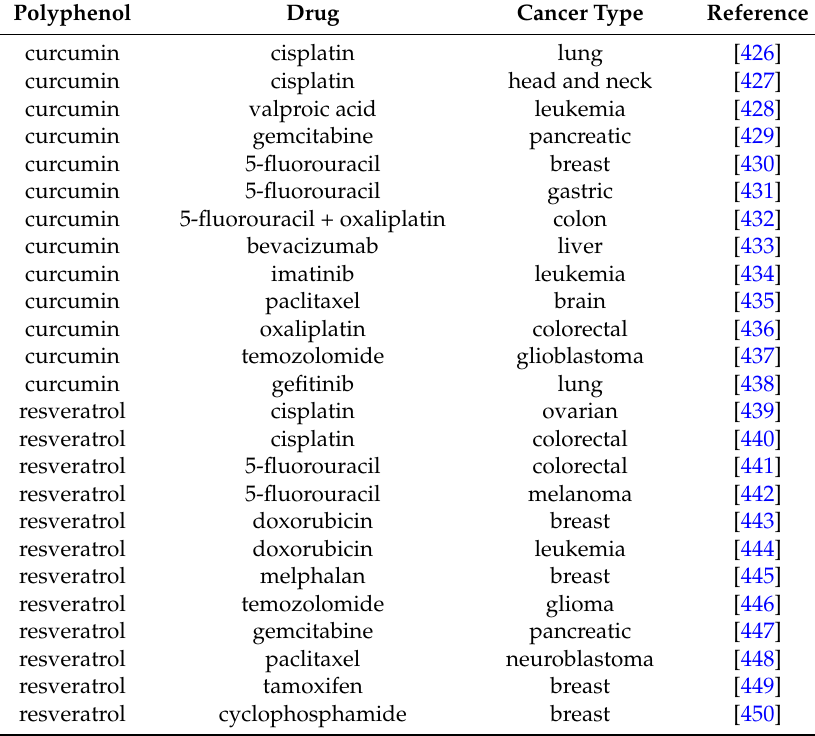
Table 6. Combination therapy of polyphenols and approved anti-cancer